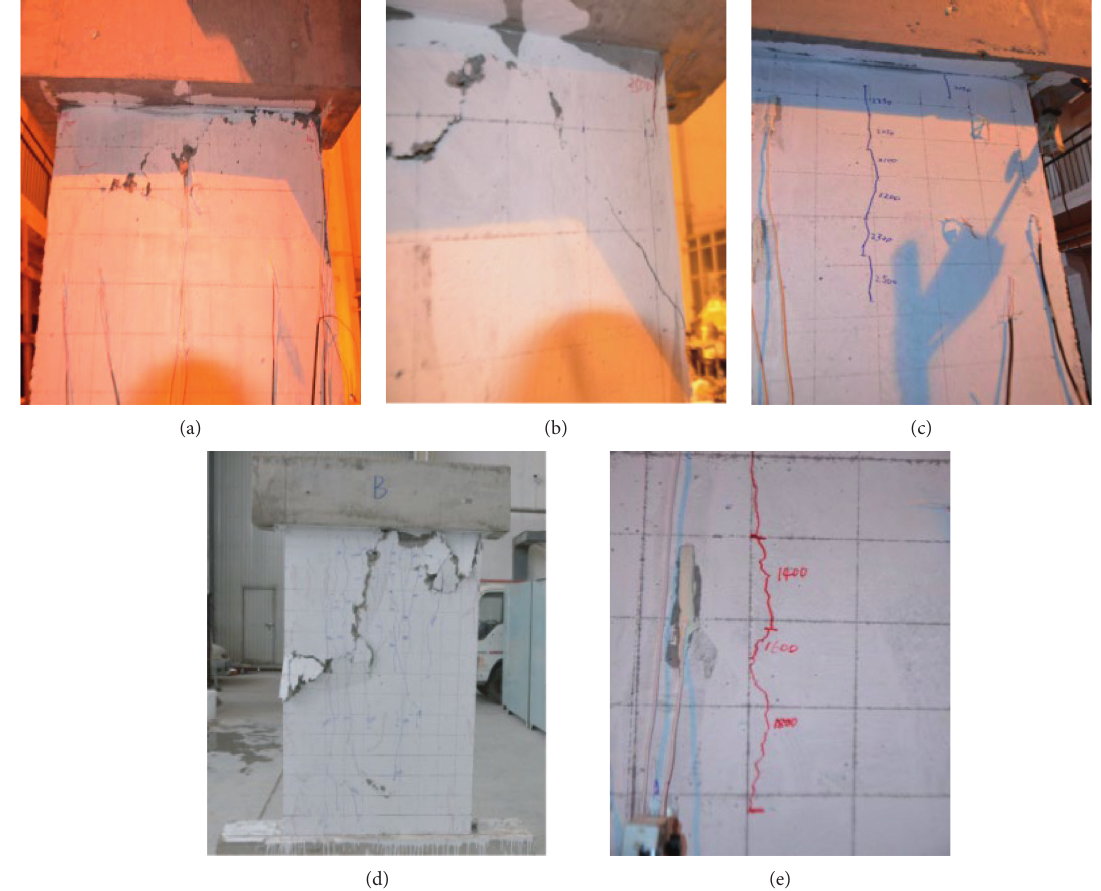
Figure 3: Failure modes and crack distribution of all specimens. (a) W1. (b) W2. (c) W3. (d) W4. (e)